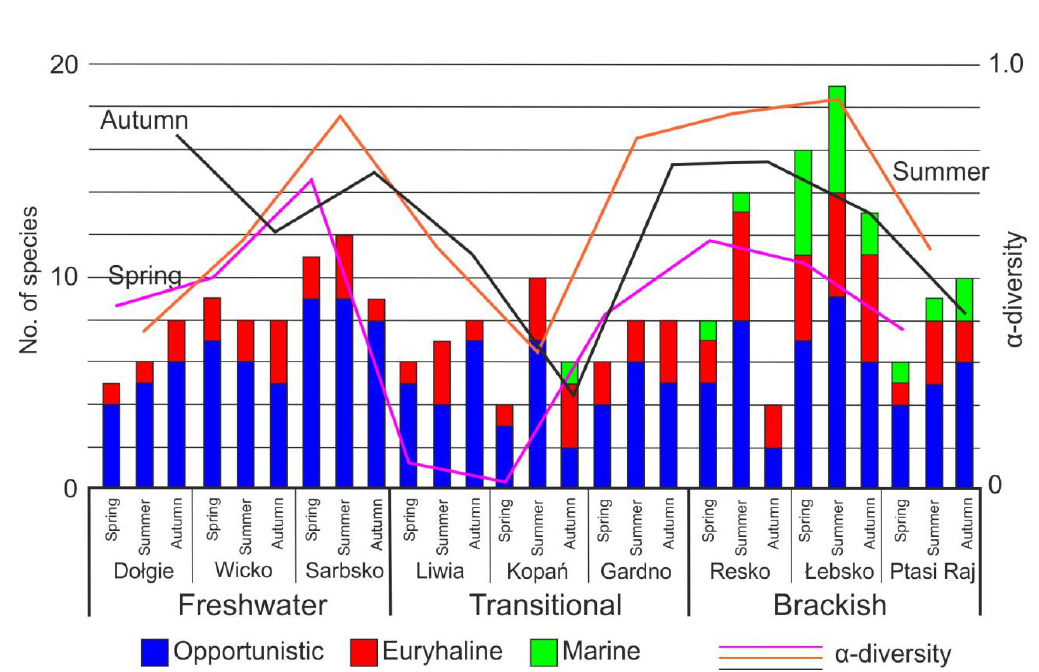
Figure 3. Richness (no of species) and α-diversity of species for each lake type in seasons.